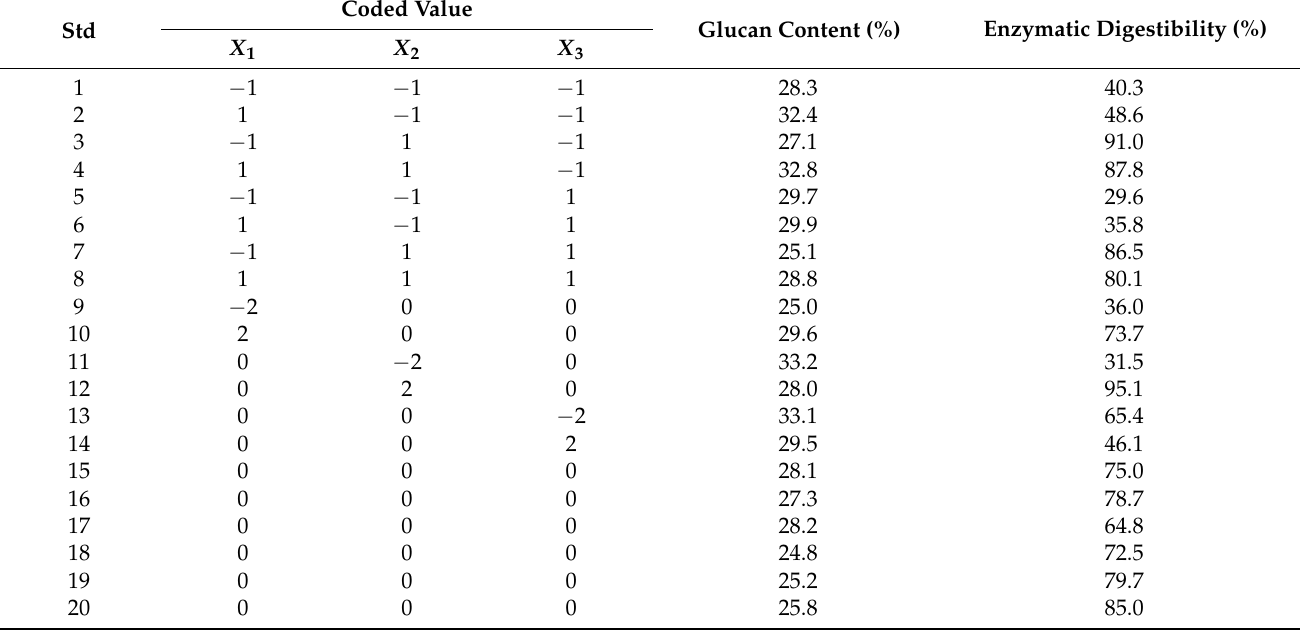
Table 3. Central composite design (CCD), experimental and estimated data for five-level-three-factor response surface analysis.